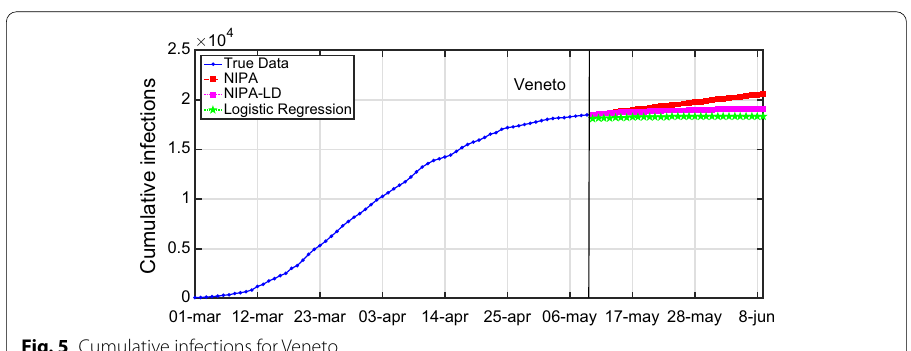
Fig. 5 Cumulative infections for Veneto